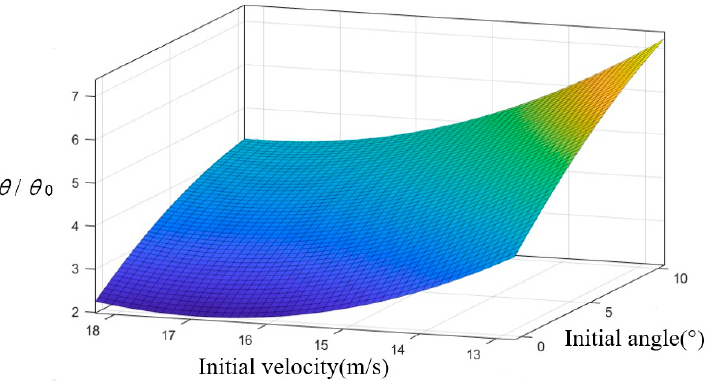
Figure 22. Fitting function image of vehicle pitch angle θ with respect to inclination angle x 1 and water-exit velocity x 2 .